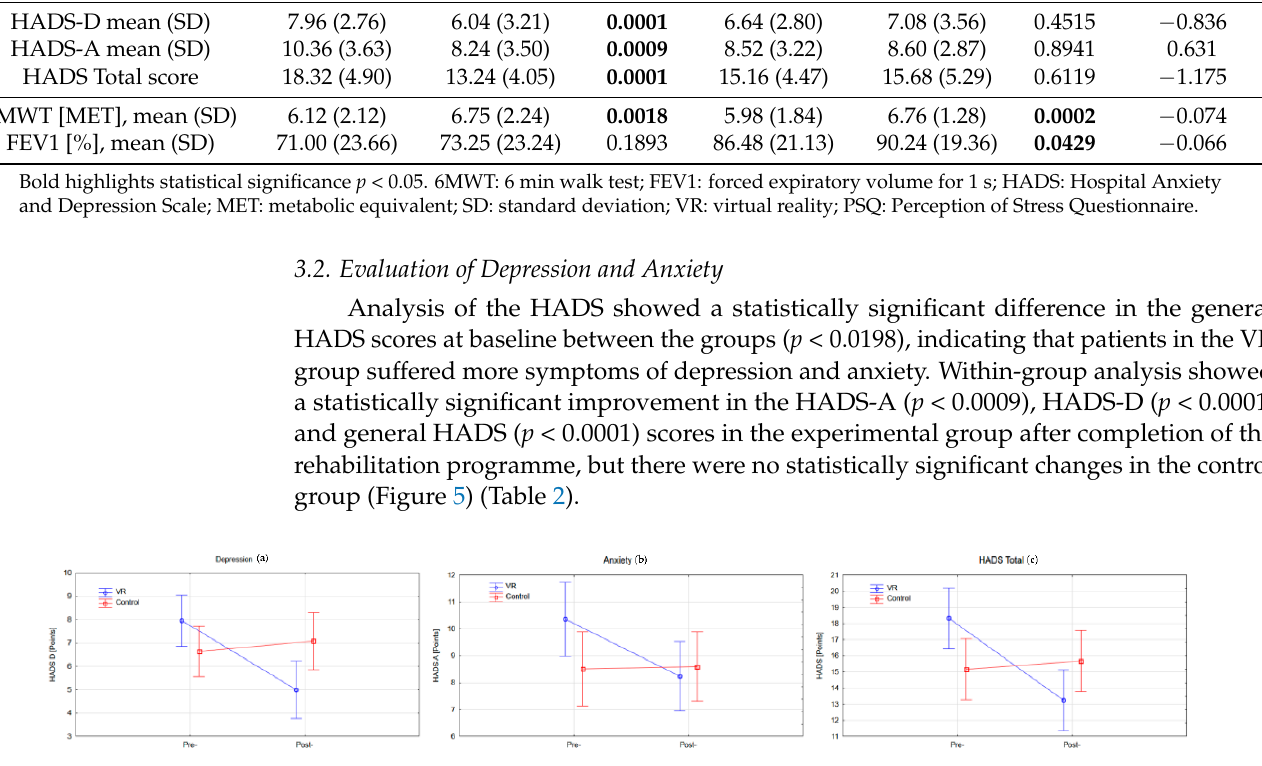
Figure 6. Analysis of the functional capacity in both groups pre- and post- rehabilitation program: ( a ) exercise capacity ( b ) pulmonary function. Table 2. Analysis of the stress, anxiety, depression, and functional capacity assessment within the examined groups ex- pressed as mean (SD). Variable